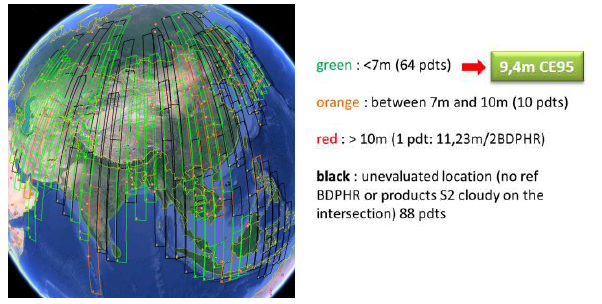
Figure 15. Asia GRI mean geolocation performance.